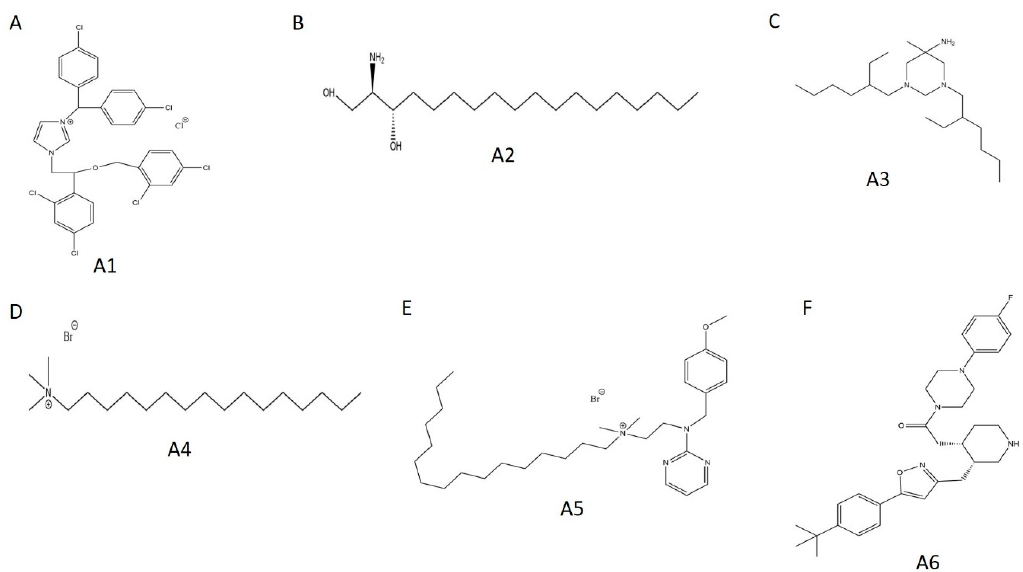
Figure 7. Chemical structures of selected WT HYPE activators. ( A ) Compound A1 . ( B ) Compound A2 . ( C ) Compound A3 . ( D ) Compound A4 . ( E ) Compound A5 . ( F ) Compound A6 . Table 2. WT HYPE activator hit information.